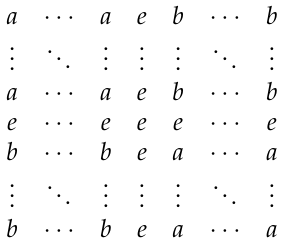
Figure 4. A picture array generated by Π 3 .